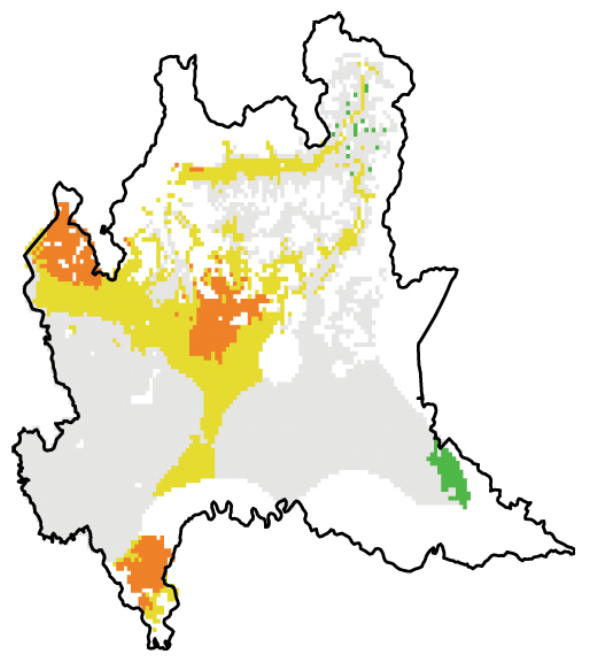
Figure 5. 8 January 2012. TN extreme events classification. Ex- treme warming: orange. Unusual warming: yellow. Normal condi- tions: grey. Unusual cooling: green. The IDI mask has been applied (see Sect. 2).